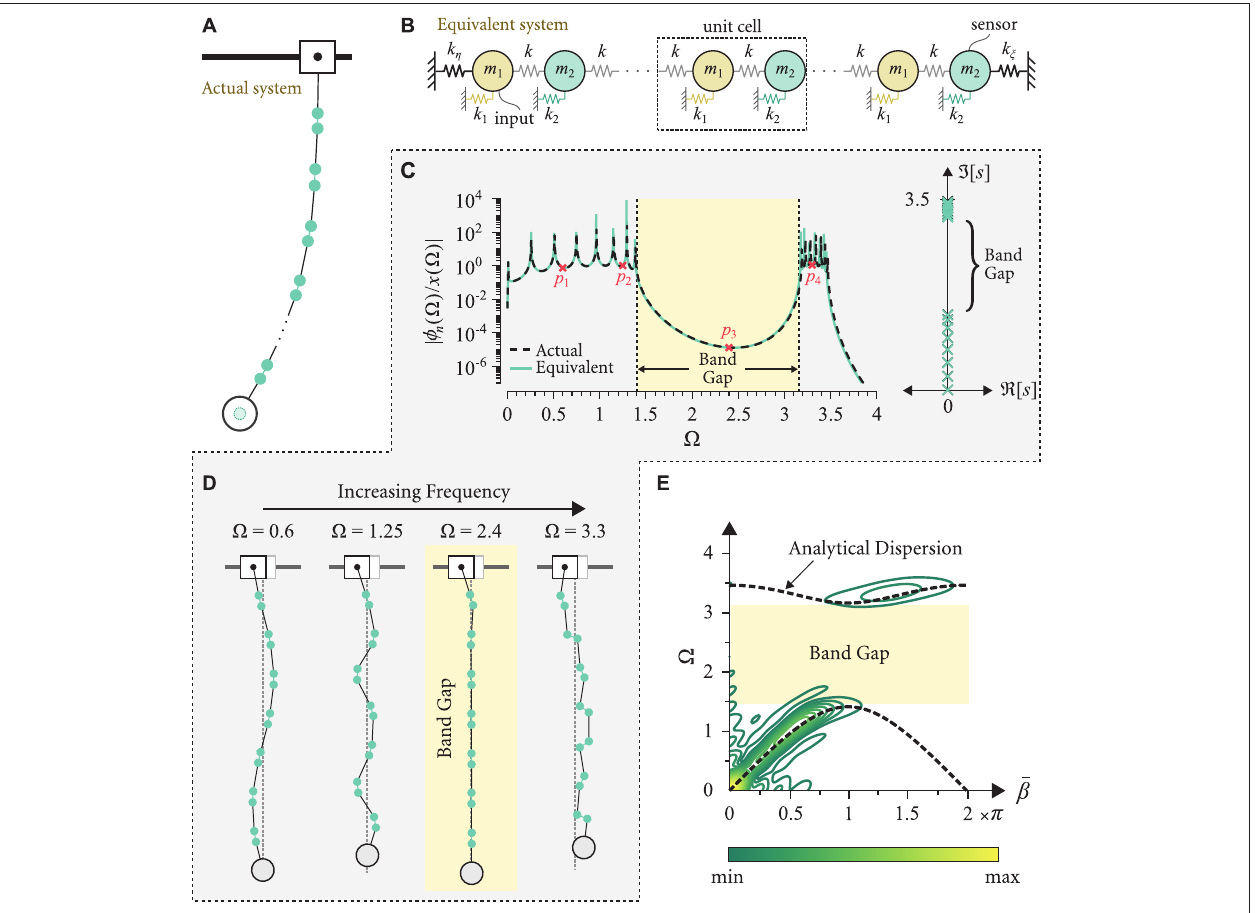
FIGURE 4 | Schematic of (A) the actual pendulum chain with linkage variations and (B) its equivalent PC lattice. (C) Frequency response diagram for the actual and equivalent systems for n 15, κ 0.2, ̺ 10 3 and ℓ 1 (left) and its corresponding poles distribution (right). (D) An illustrative schematic of the steady state = = = = responses of the pendulums with varying linkage at four distinct excitation frequencies (marked p 1 4 on the frequency response). (E) Numerical dispersion contours − constructed from the actual chain of pendulums showing agreement with the analytical dispersion relations (black dashed-line) obtained from the equivalent system via Equation